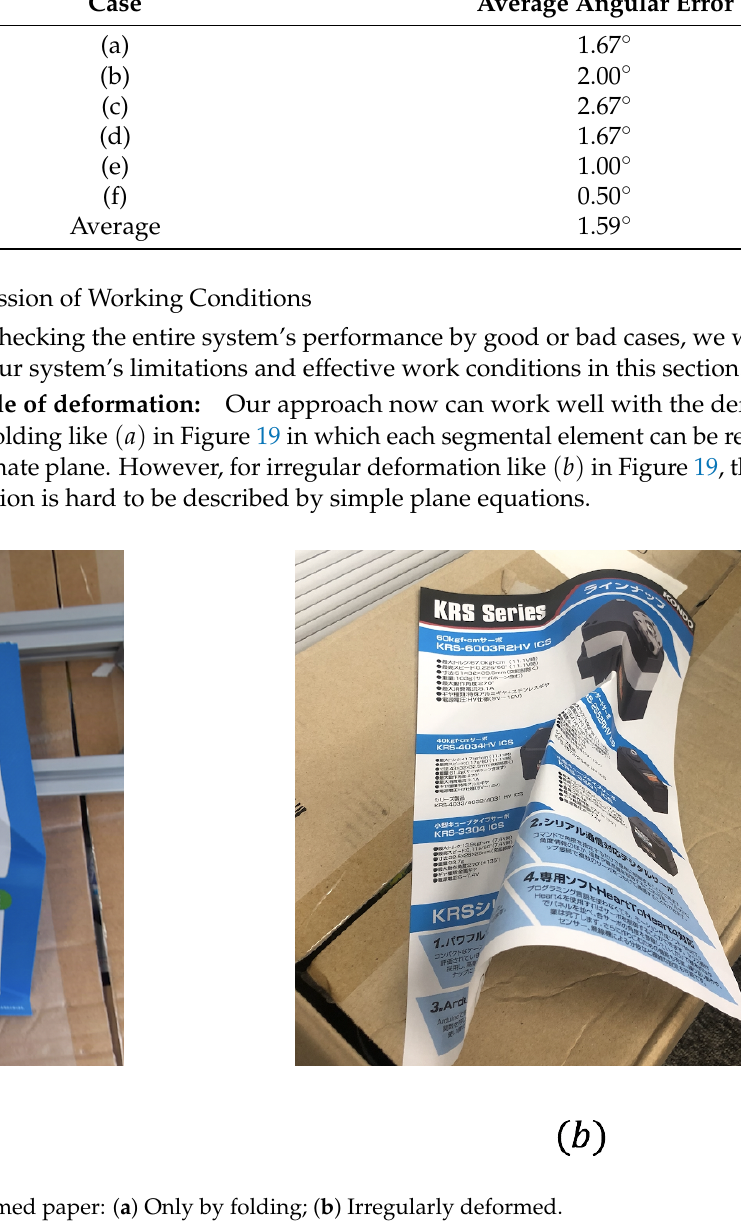
Figure 19. Deformed paper: ( a ) Only by folding; ( b ) Irregularly